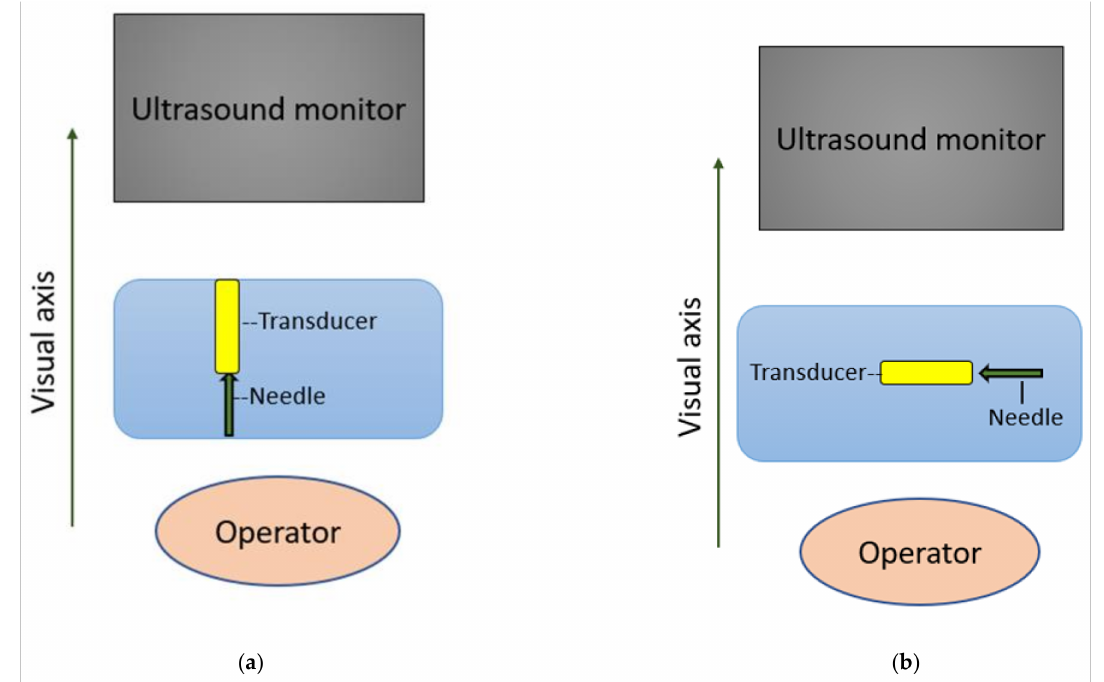
Figure 9. ( a ) In-plane needling where the ultrasound monitor, transducer, needle and operator are along the visual axis improves needle visualisation. ( b ) In-plane needling where the transducer and needle are across the visual axis impairs needle visualisation.